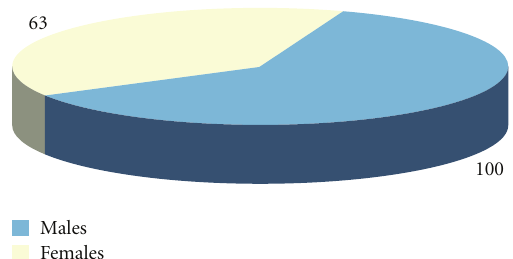
Figure 1: Diagnosed peritonsillar abscesses: Male to Female ratio in our 10-year series (1999–2009).